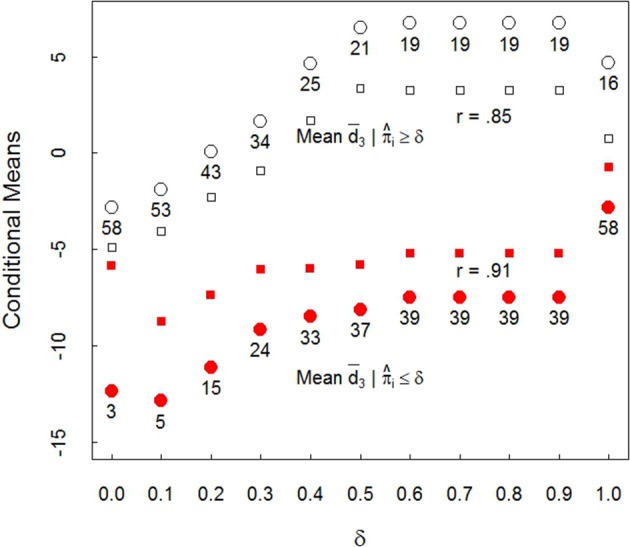
Three month infant plot of means d¯3|π^≤δ, filled circles and d¯3|π^≥δ unfilled circles, against δ. Filled and open squares are standard errors. r is the conditional mean with δ correlation. Numbers display sample size in each mean.